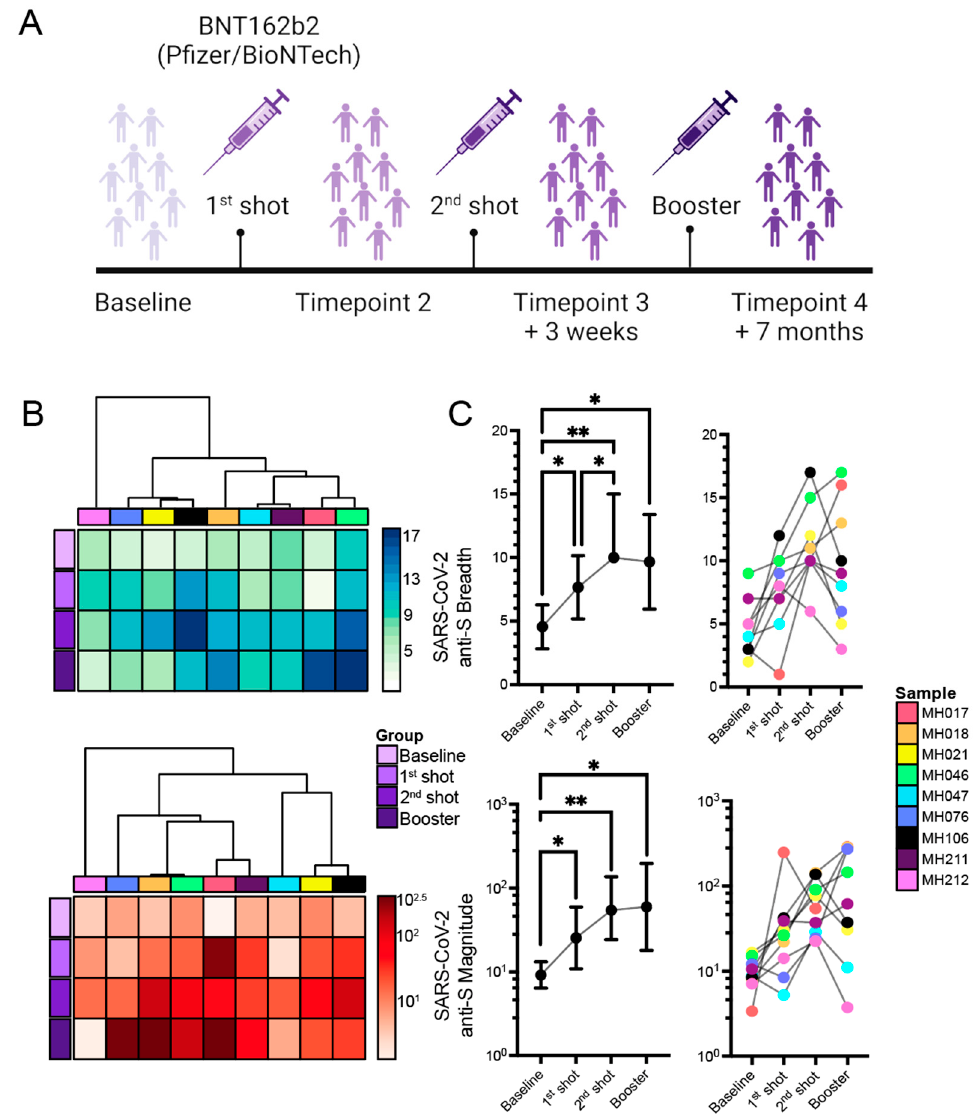
Figure 1. Comparing the breadth and magnitude of anti-S responses across vaccination timepoints. ( A ) Longitudinal study design. Breadth (top panel) and log-scaled average magnitude (bottom panel) of responses represented as ( B ) heatmaps with subject-level hierarchical clustering, ( C ) Median (IQR) responses (left) with before and after plots highlighting individual response patterns (right) are illustrated. 1-correlation was used as a distance measure with single linkage for hierarchical clustering of subjects. Statistically significant pairwise comparisons of vaccination timepoints are indicated with asterisks (Wilcoxon matched signed-rank test). p -values are denoted: ** p < 0.01, * p < 0.05.